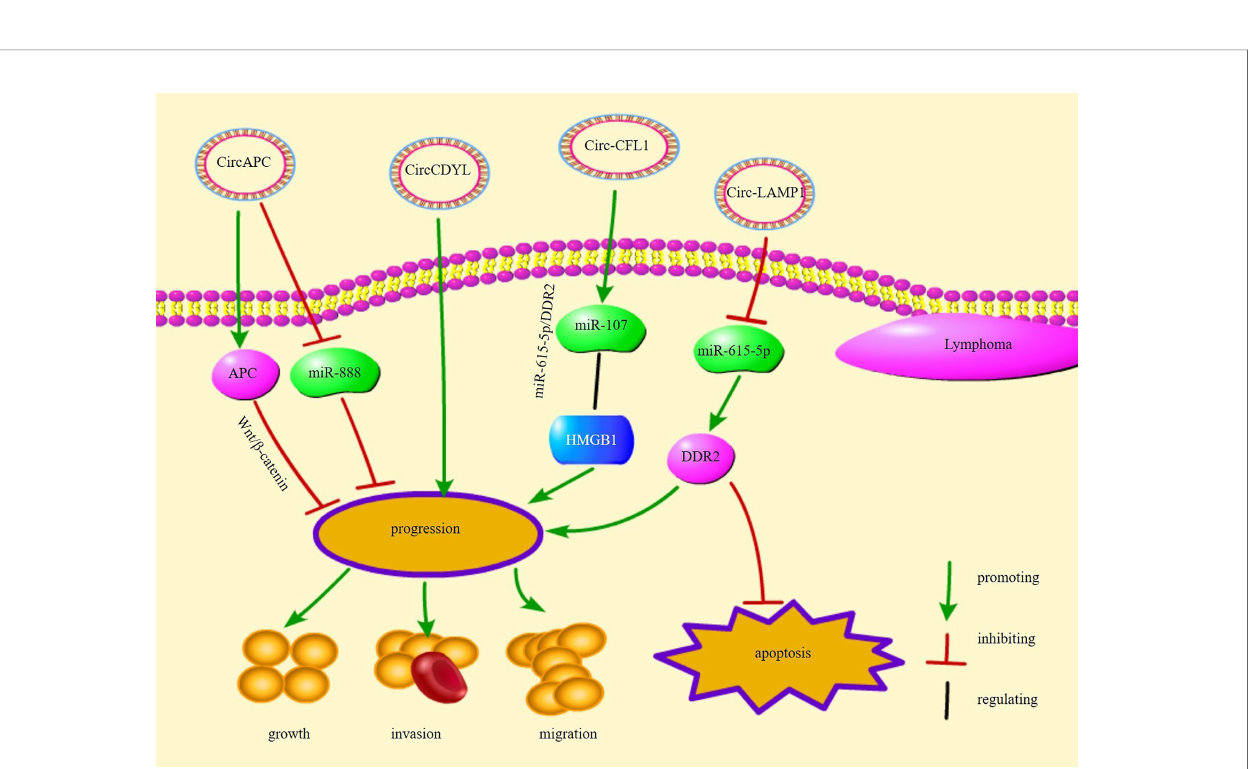
FIGURE 2 | The regulatory mechanisms and their functions of circRNAs in